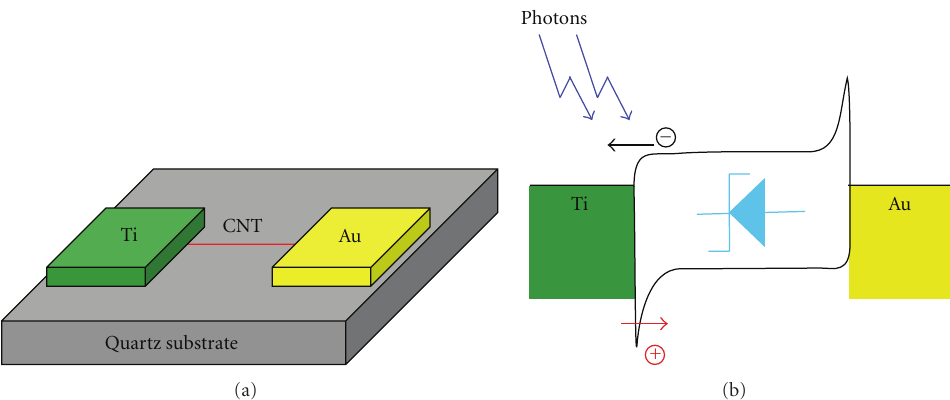
Figure 1: (a) The basic structure of a CNT photodetector, consisting of a CNT connecting to Ti and Au electrodes on top of a quartz substrate. (b) The band diagram of the CNT